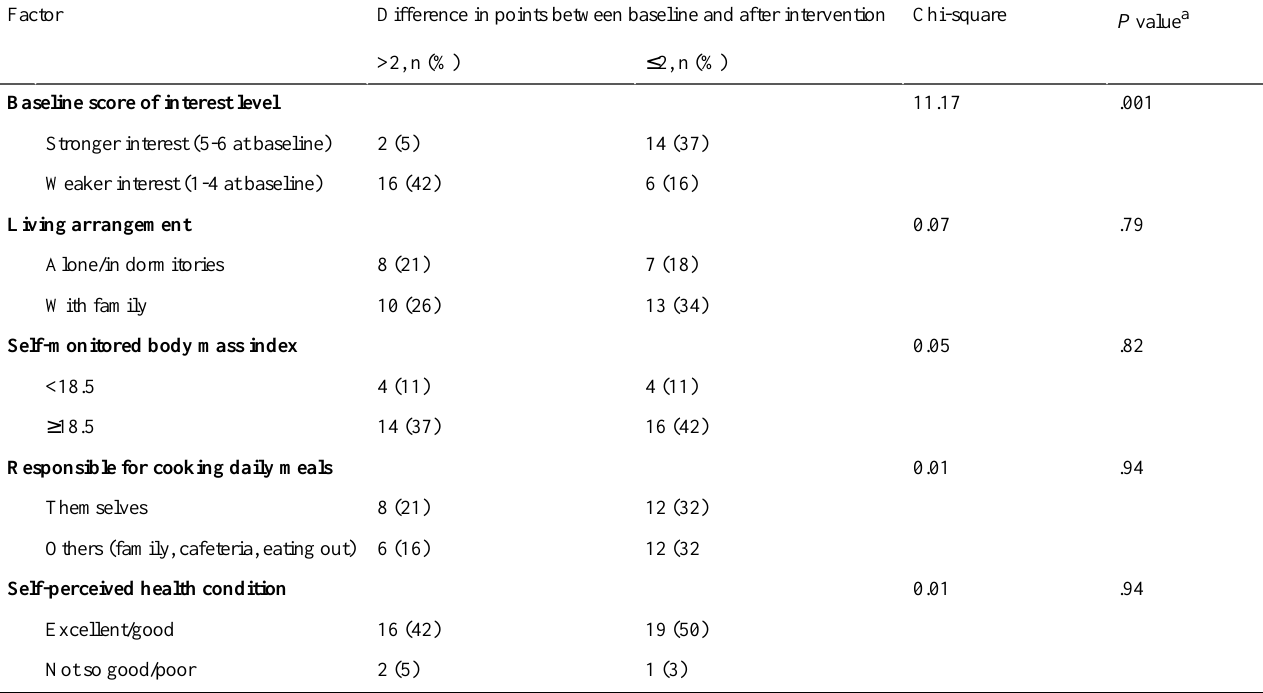
Table 3. Factors affecting participants with substantial changes in their scores of interest level through the intervention (N=38).